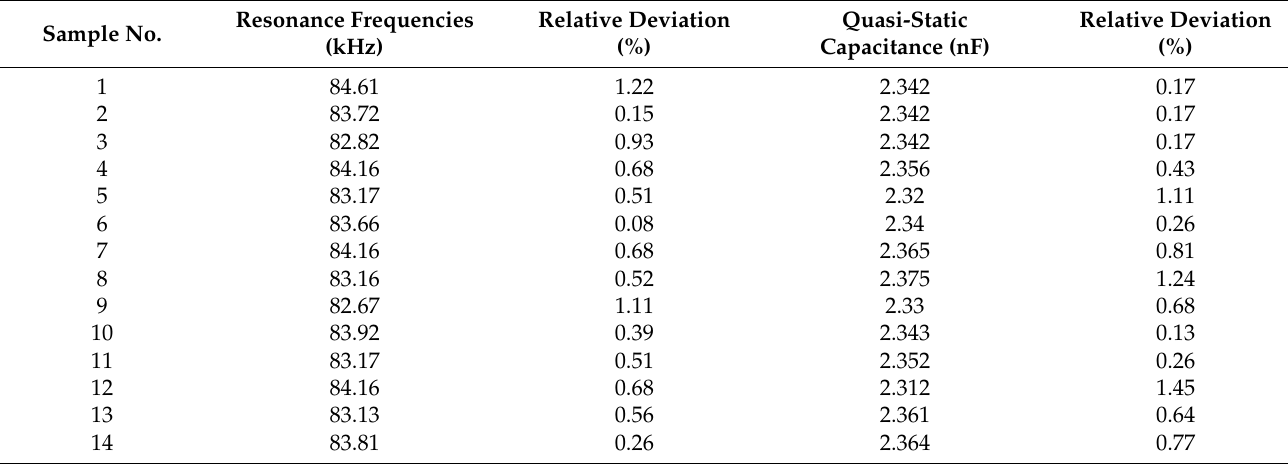
Figure 7. Diagrams of array elements. Table 3. Electrical performances of array